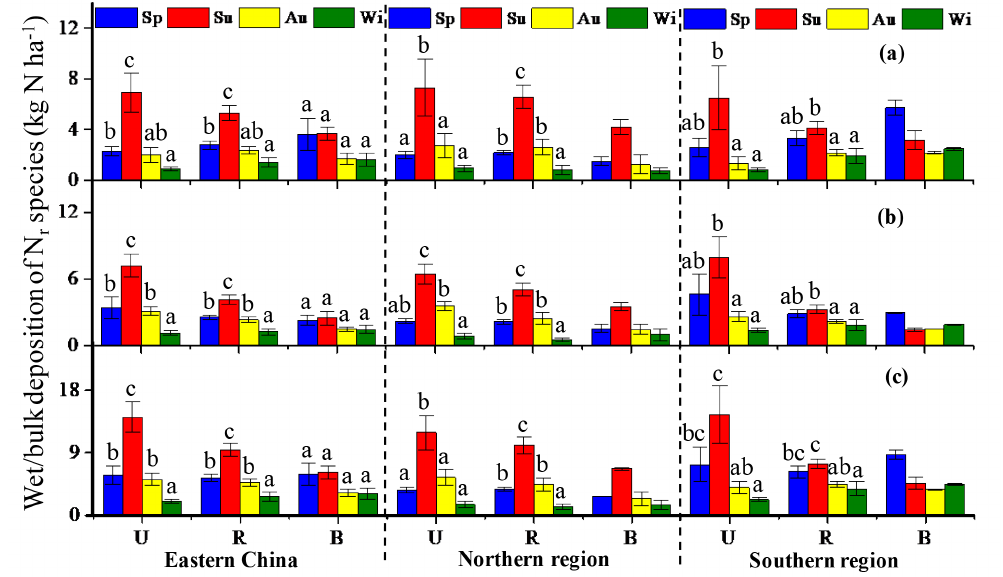
Figure 7. Seasonal mean wet/bulk deposition averaged over 2011-2015 of NH + (c) , in precipitation at different land use types in eastern China and its northern and southern regions. Sp, Su, Au, and Wi NH + and NO − 4 3 represent spring, summer, autumn, and winter respectively. U, R, and B denote urban, rural, and background sites respectively. The number of sites for each land use type in each region can be found in Table 2. The error bars are the standard errors of means, and values without same letters on the bars denote significant differences between the seasons ( p <0.05).